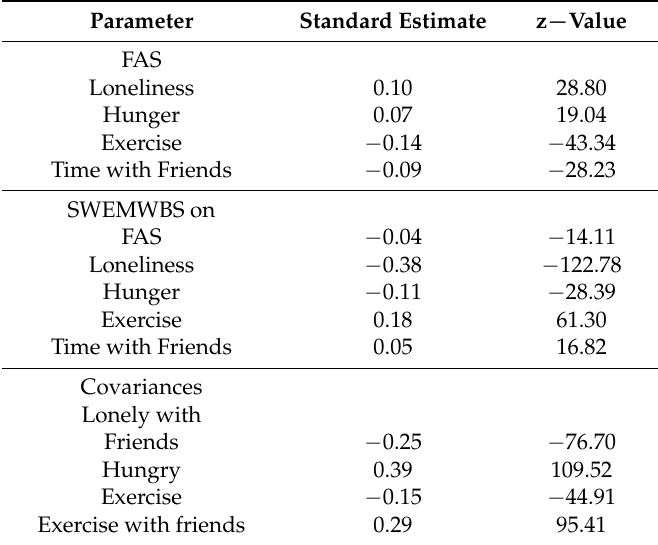
Table 3. Standardised path coefficient estimates of Family Affluence Scale (FAS) score and summer holiday experiences on student mental wellbeing (SWEMWBS